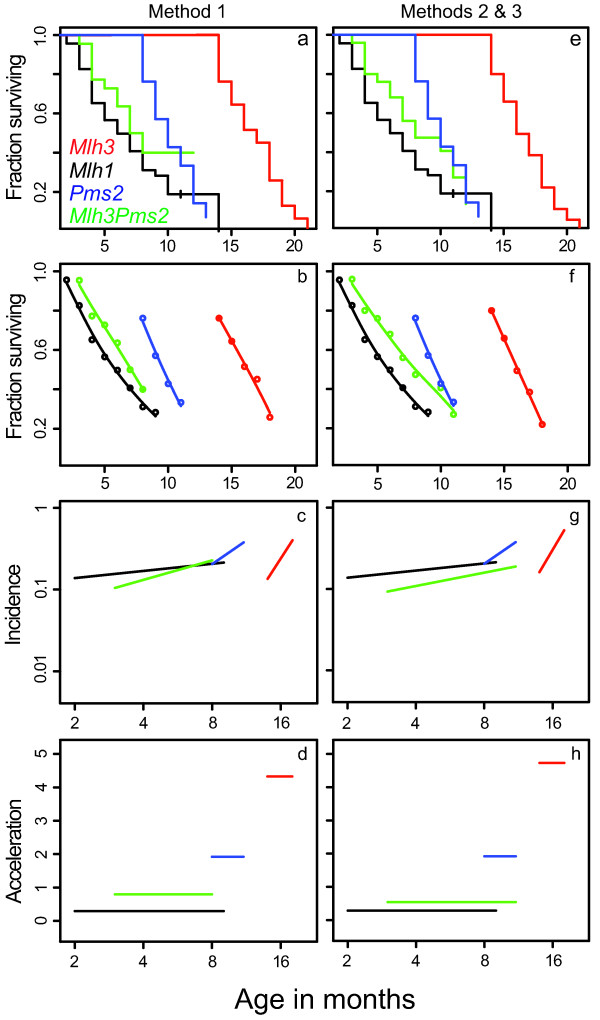
Lymphoma kinetics for four MMR knockout mouse genotypes. Lymphoma data plotted with the same style as the plots in Figure 1. The columns show the different methods for dealing with the 7 mice who had GI carcinomas, as explained in the text. Methods 2 and 3 are equivalent for analysis of the lymphoma data.